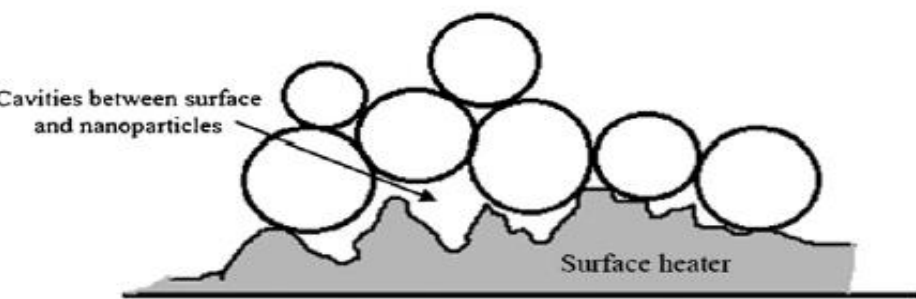
Figure 9. Schematic diagram of the deposition of nanoparticles on a heated surface [78].